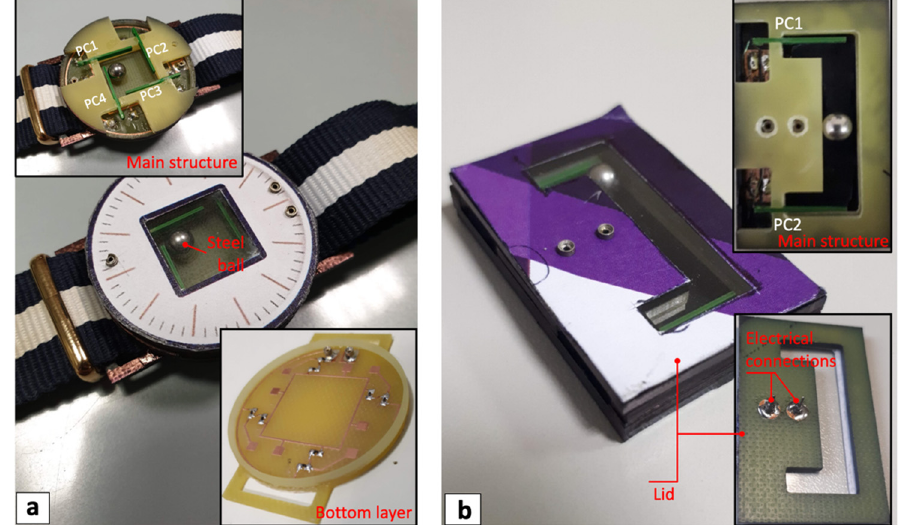
Figure 8. Images of the mono-axial ( a ) and bi-axial ( b ) multi-converter harvester prototypes with views of the main structures, bottom layer, and lid.